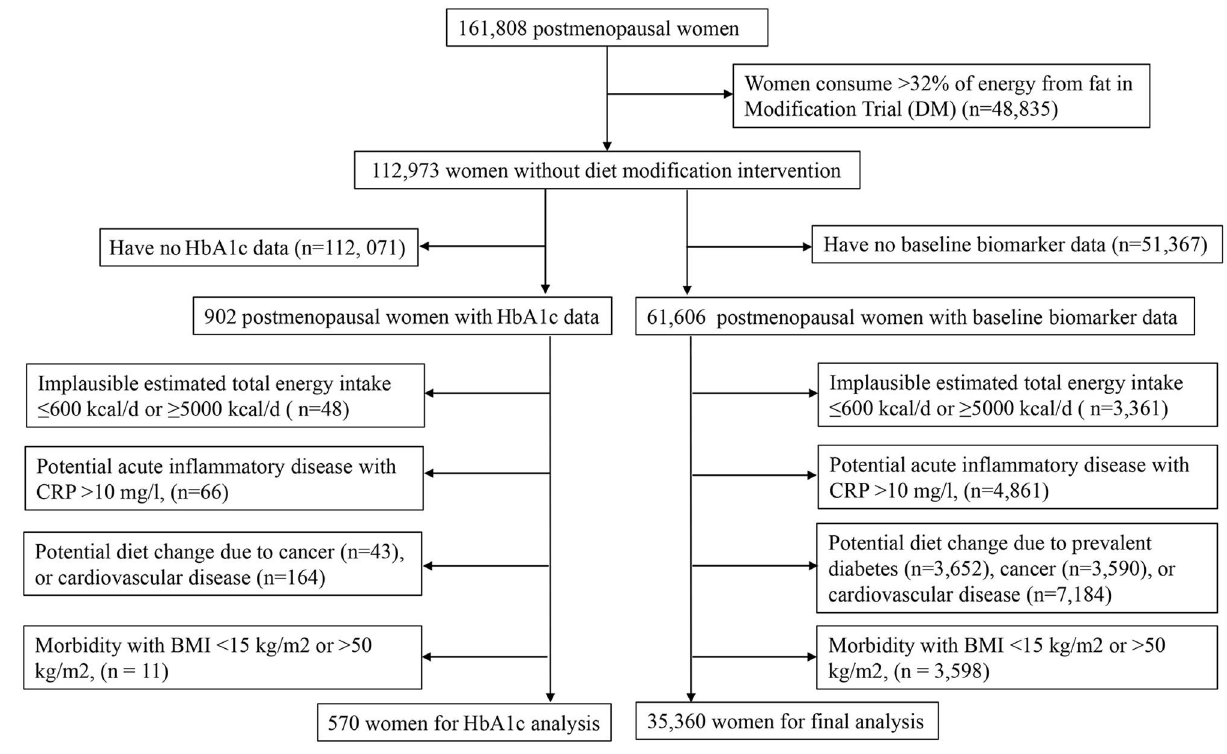
FIGURE 1 | A flow chart for eligible participants enrolled in the Women’s Health